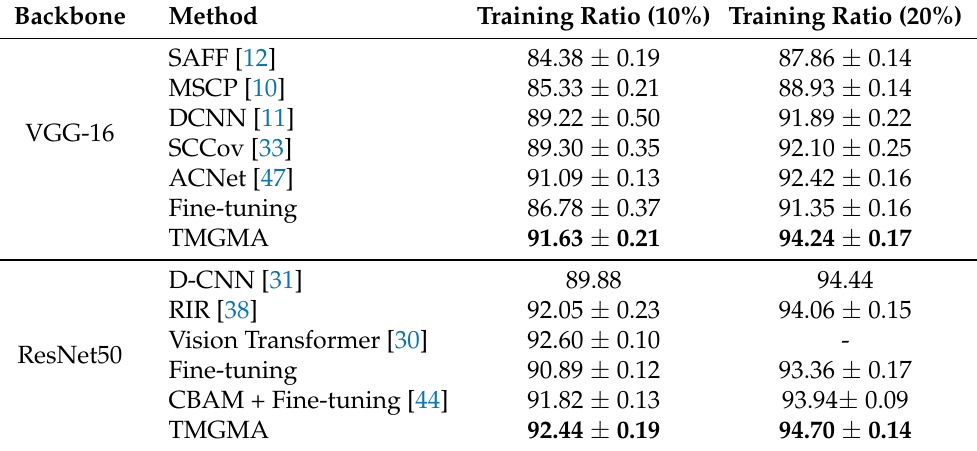
Table 3. Classification accuracies (%) of the proposed TMGMA and other methods on the NWPU- RESISC45